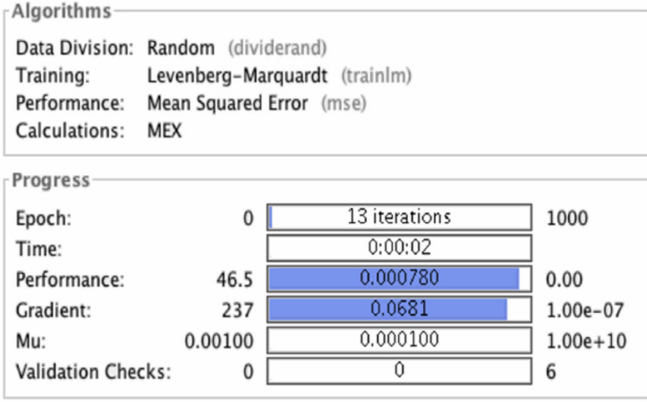
Figure 10. ANN model training of model